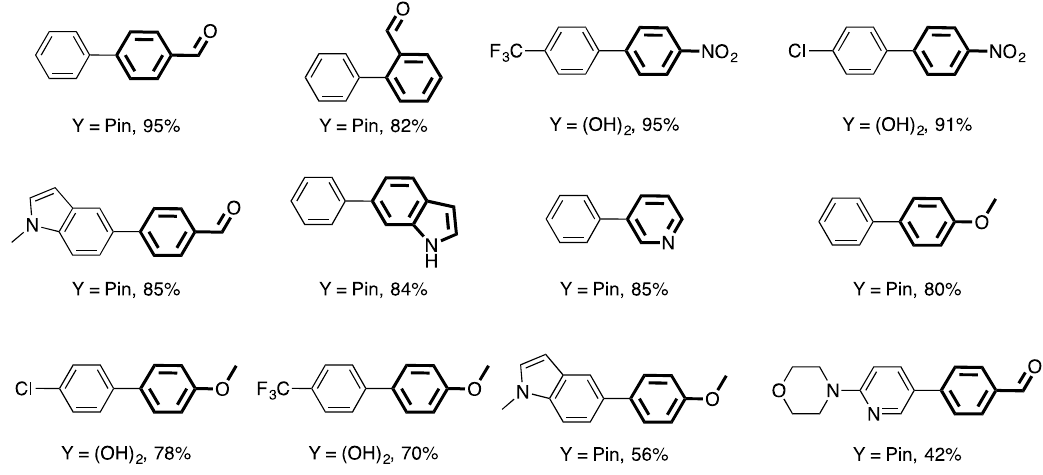
Figure 5. Substrate scope of continuous flow Suzuki–Miyaura cross-coupling sequence using immobilized Pd on MOFs.